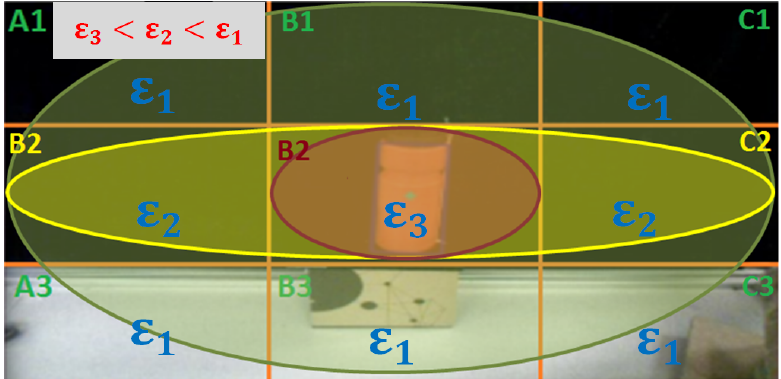
Figure 12. Selection of the Error Priority in the different quadrants of the